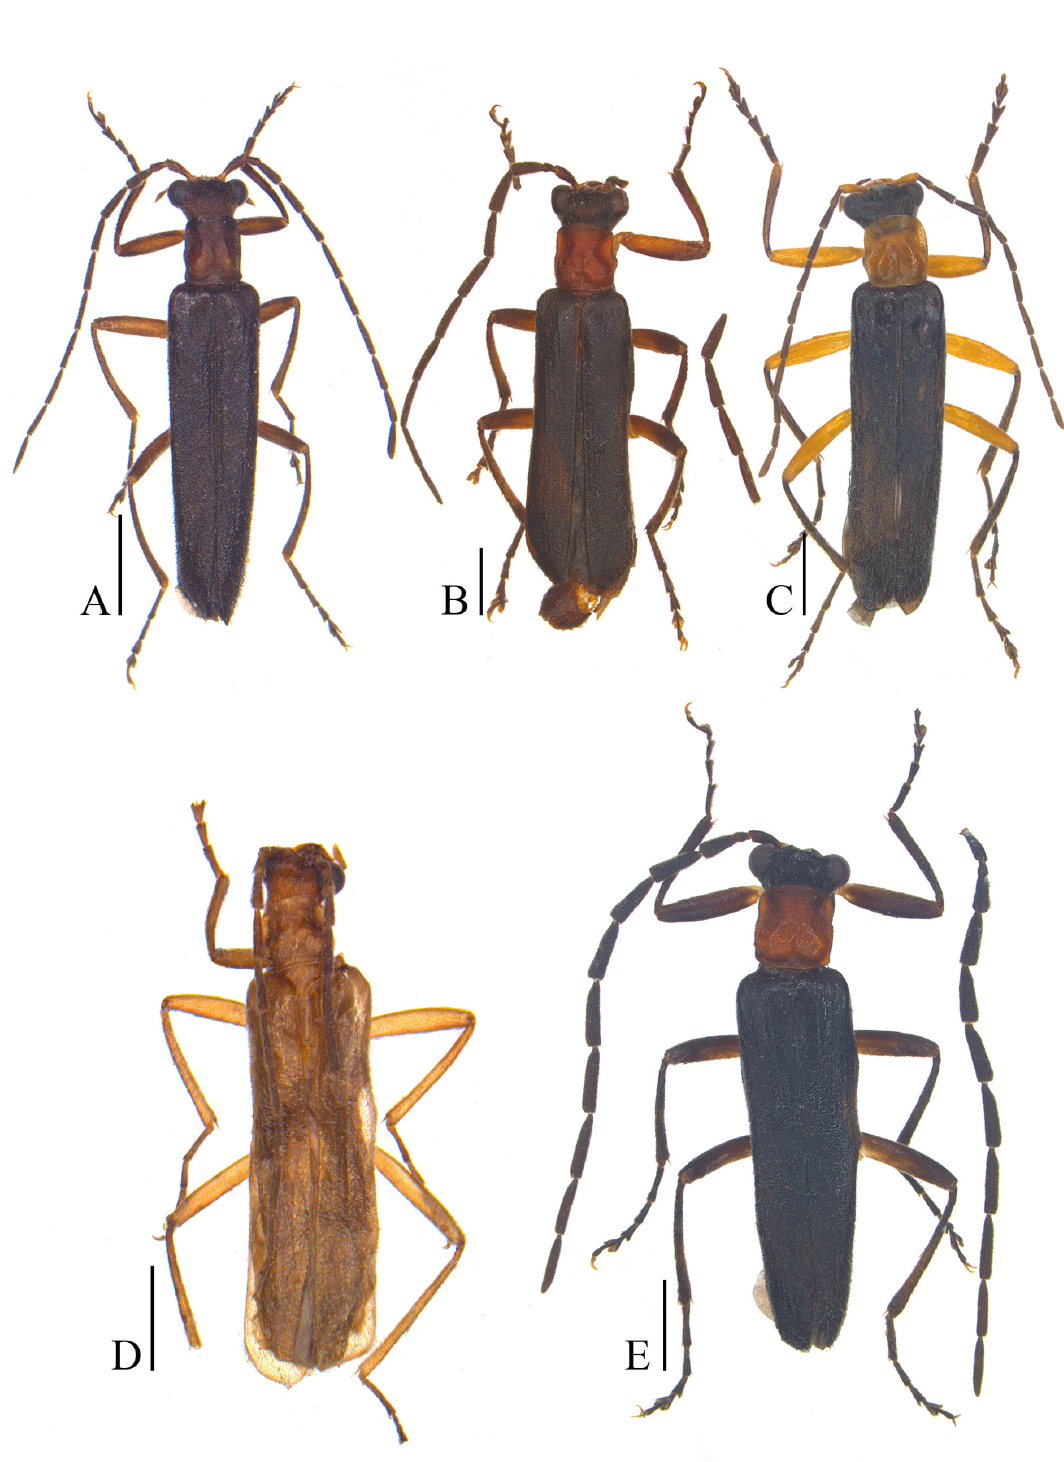
Fig. 9. Habitus, dorsal view. A . Stenothemus gracilis Y. Yang & X. Yang sp. nov., holotype, ♂ (MHBU HBU(E) 410022). B . S. chongqingensis Y. Yang & H. Liu sp. nov., holotype, ♂ (MHBU HBU(E) 410028). C . S. flavicollis Y. Yang & S. Ge sp. nov., holotype, ♂ (MHBU HBU(E) 410029). D . S. jindraimimus Y. Yang & X. Yang sp. nov., holotype, ♂ (IZAS IOZ(E) 1389239). E . S. laticornis Y. Yang & H. Liu sp. nov., holotype, ♂ (MHBU HBU(E) 410045). Scale bars = 1.0